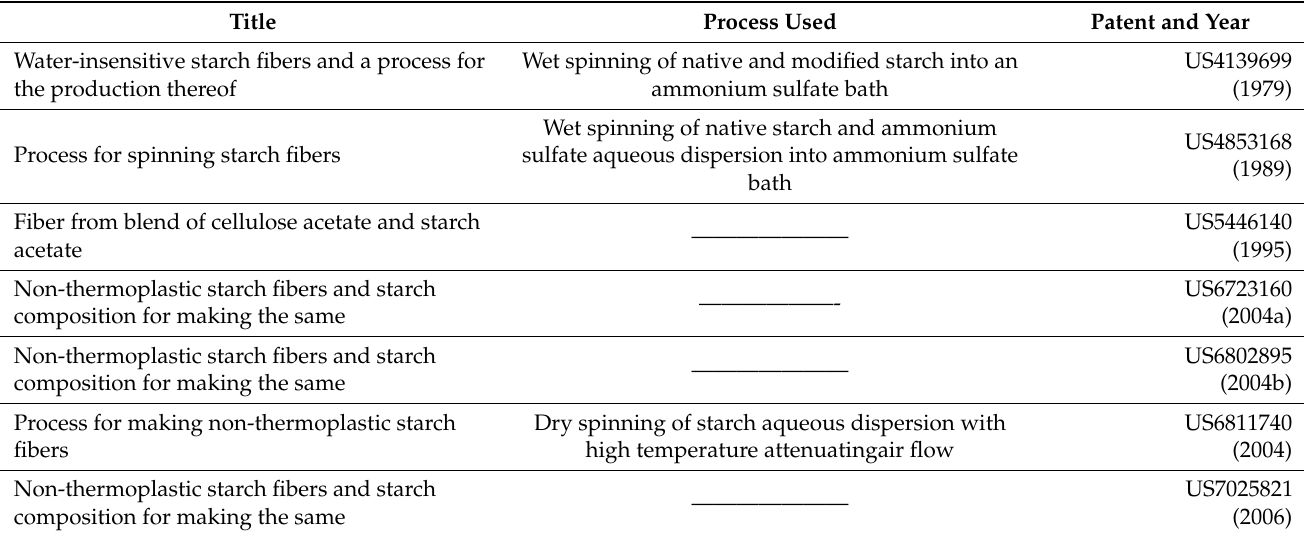
Table 2. Fibers spun from non-thermoplastic starch composition (NTPSC)